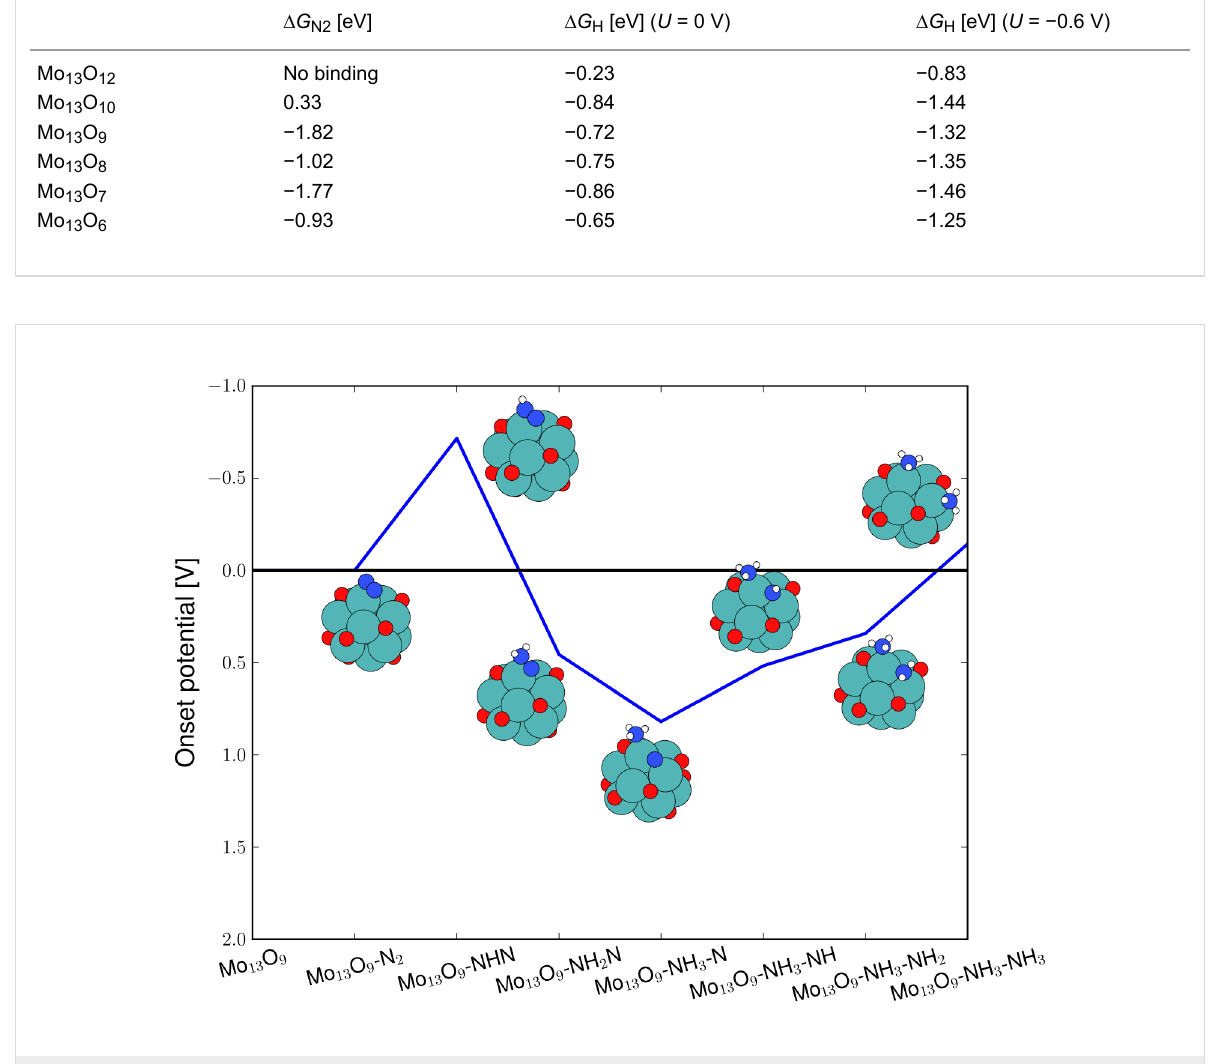
Figure 4: Diagram of the required applied potential to make each reaction step exergonic for electrochemical ammonia production on the Mo 13 O 9 through the associative mechanism. For all five studied reaction pathways, the highest required potential is − 0.7 V for the first protonation